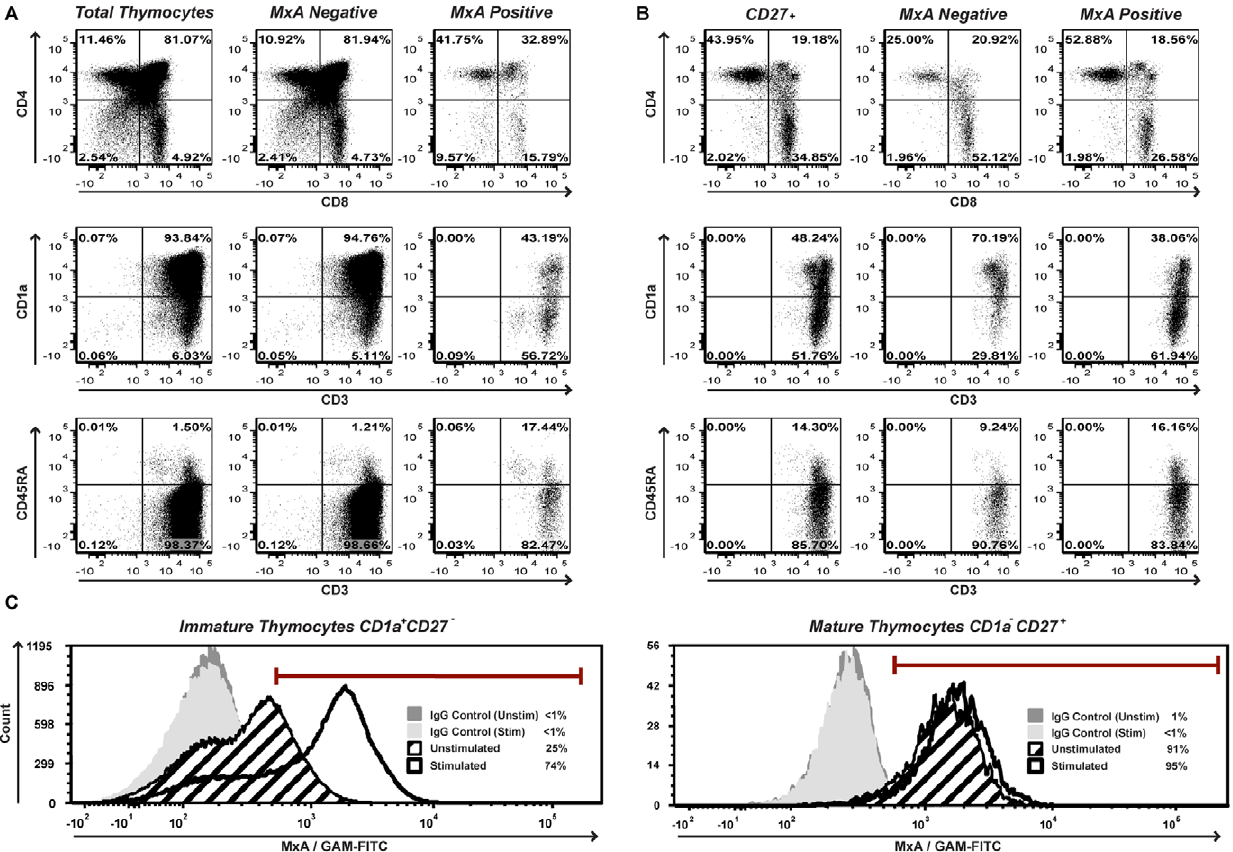
Figure 3. MxA is preferentially expressed in mature thymocytes and exogenous IFN- a only upregulates MxA in immature CD1a + CD27 2 thymocytes. A, B, Total thymocytes were stained for surface expression of CD4, CD8, CD1a, CD3, CD27, CD45RA and CD123 combined with intracellular MxA expression. A, Differences of thymocyte subset expression patterns in all thymocytes, MxA negative and positive cells are shown. B , Differences of thymocyte subset expression patterns in CD27 + , MxA negative and positive cells are shown. C, Total thymocytes were cultured in the presence or absence of 1000 U/mL IFN- a overnight. Cells were stained for surface expression of CD4, CD8, CD1a, CD3, CD27, CD45RA and CD123 combined with intracellular MxA expression. MxA expression in immature and mature thymocyte subsets was determined by gating on CD1a + CD27 2 and CD1a 2 CD27 + cells respectively.